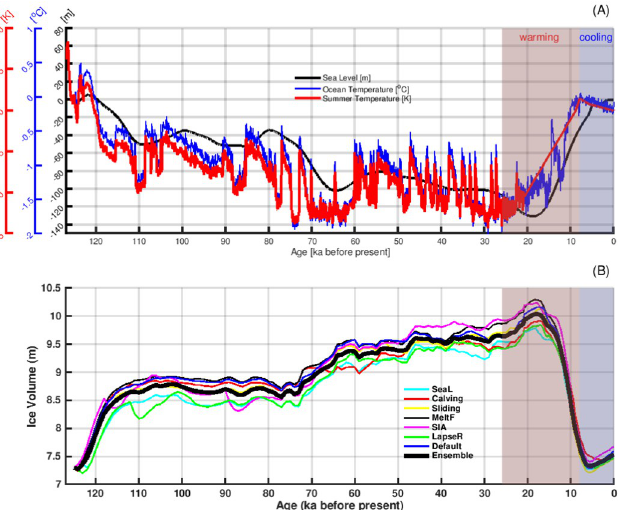
Fig 4. The evolution of Greenland’s climate and simulated ice volume of the GrIS from the last interglacial to the Pre-Industrial era. (A): The prescribed forcing of summer (JJA) atmospheric temperature (red line), yearly mean ocean temperature (blue line) and global mean sea level (black line). (B): The simulated ice volume evolution of the GrIS. The coloured lines are the results from individual ensemble members (see Table 1). The thick black line gives the ensemble mean values. The red shadow area marks the time period when Greenland’s climate gets warmer, and the blue patch illustrates the time when Greenland’s climate colds.